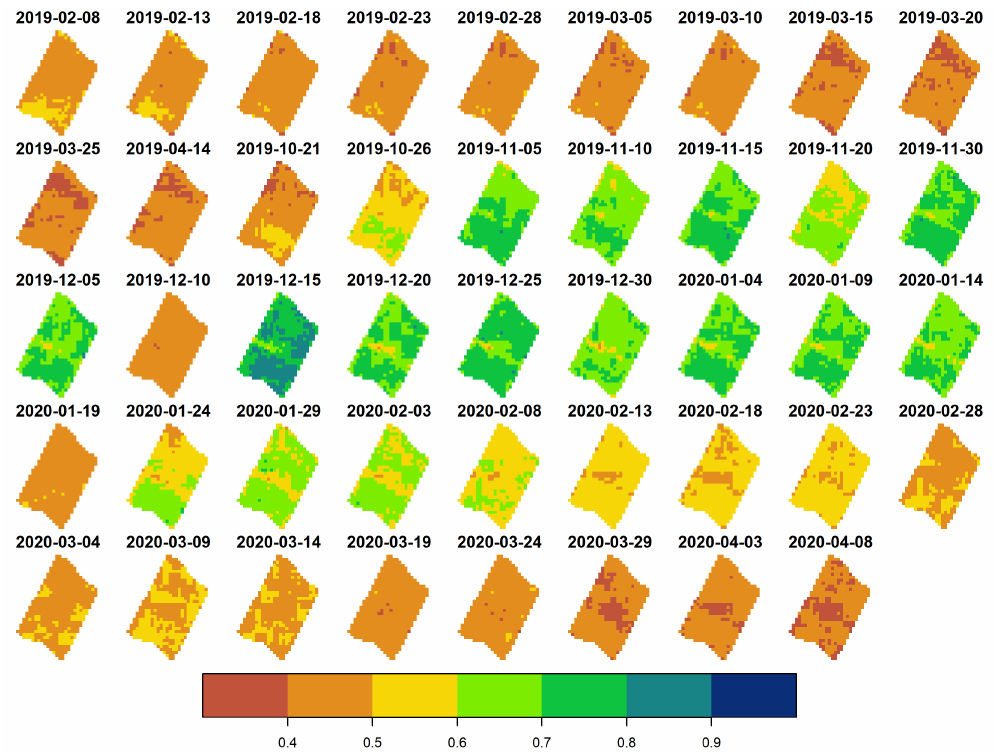
Figure 4. CARI time-series for selected